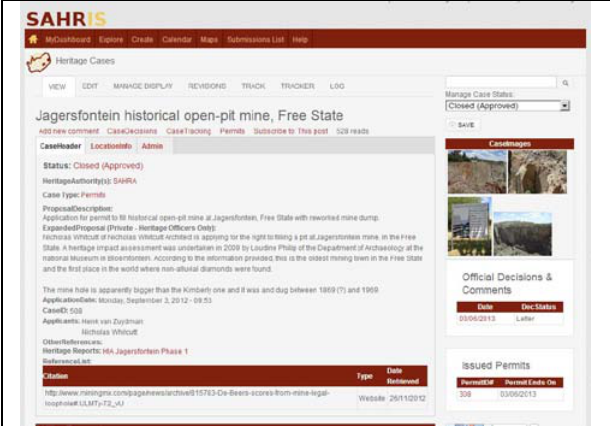
Figure 2. View of a development application on SAHRIS impacting an historical